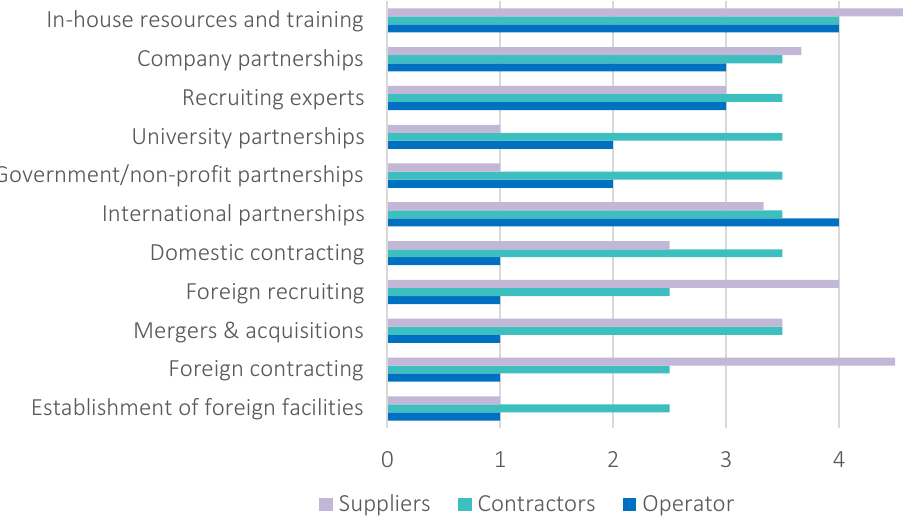
Figure 4. Future competence and skills needed to perform new remote operation activities